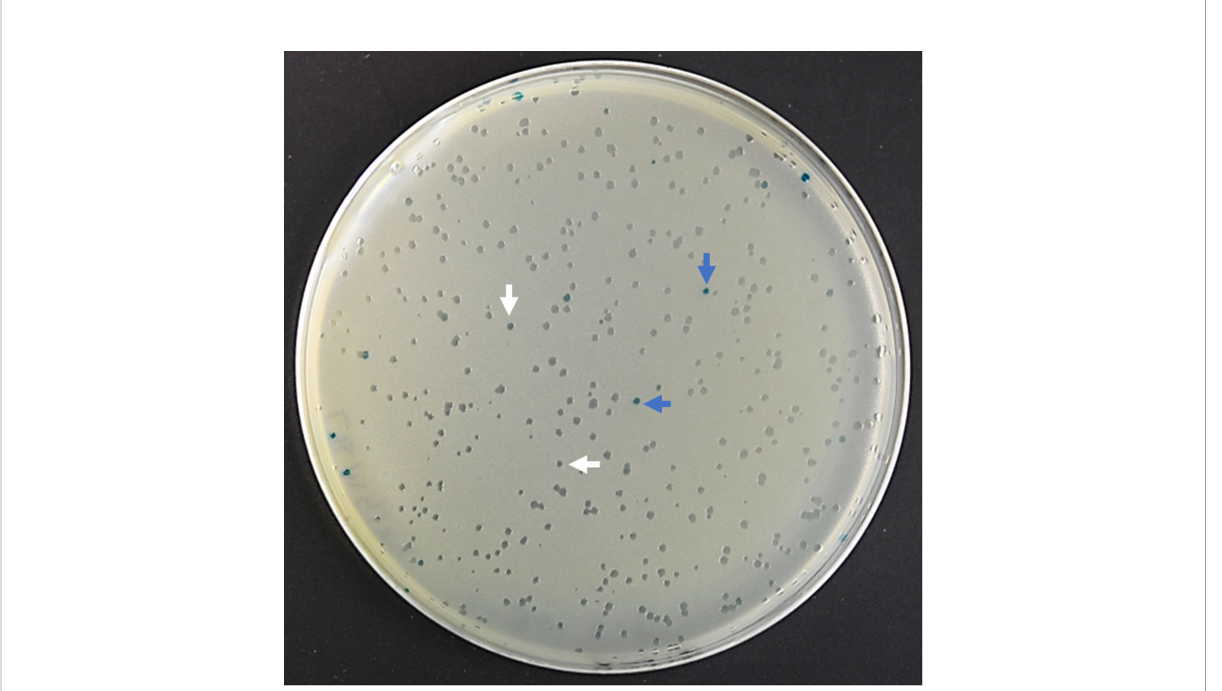
FIGURE 3 The ef fi ciency of recombinant phage cDNA library. To determine the percentage of recombinant clones, blue – white screening was performed on LB/MgSO4 agar plates containing IPTG and X-gal. White plaque indicates recombinant plaque and blue plaque indicates nonrecombinant